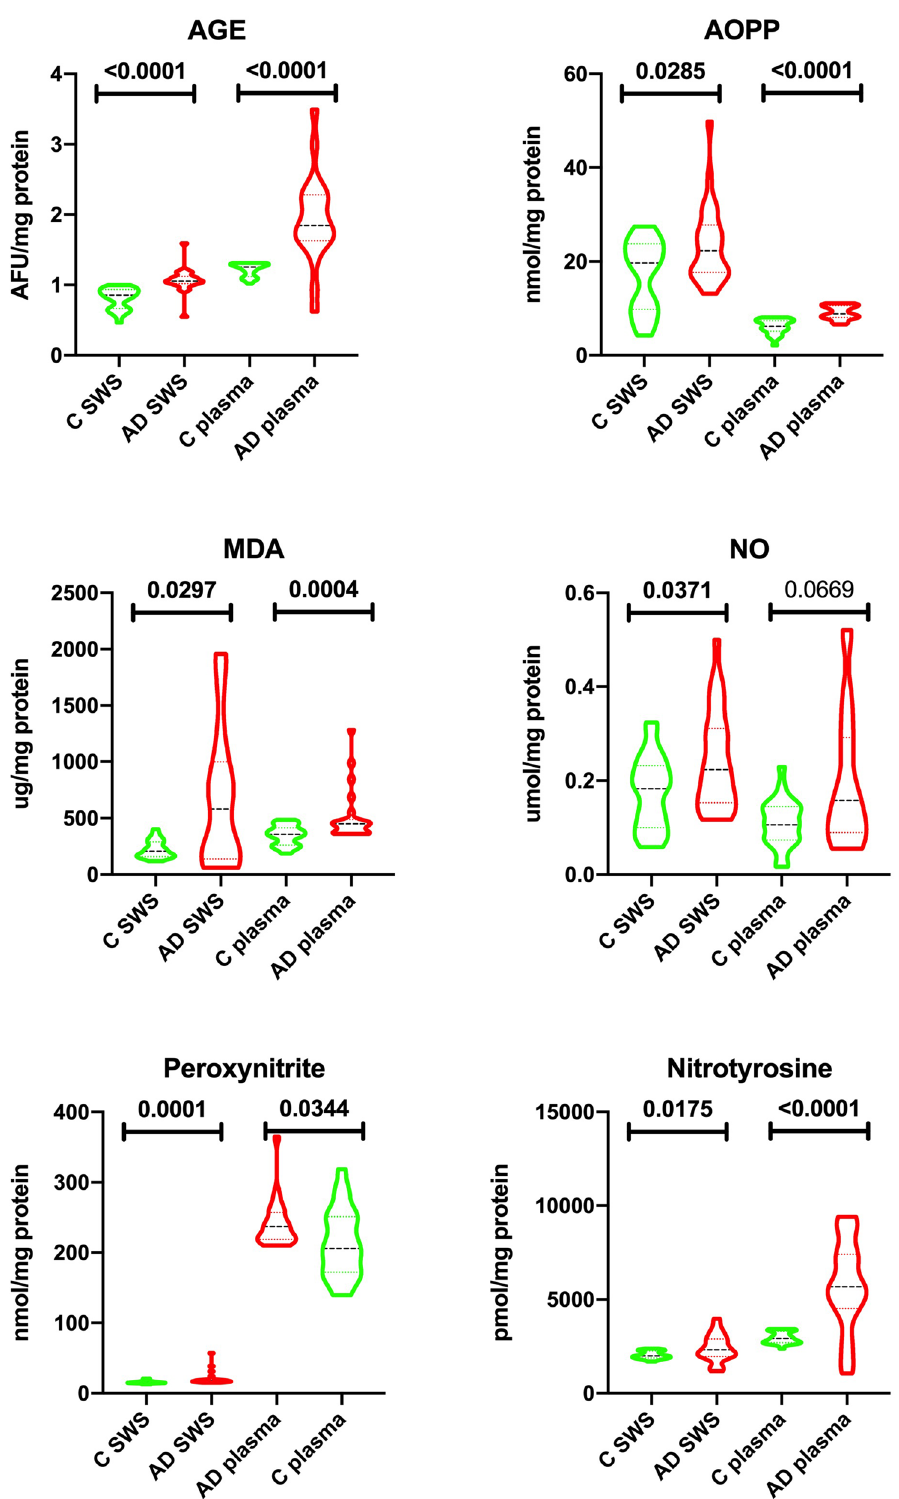
Figure 4. Salivary and erythrocytes/plasma oxidative and nitrosative stress in patients with Alzheimer’s disease and the control group. AGE—advanced glycation end products; AOPP—advanced oxidation protein products; MDA—malondialdehyde; NO—nitric oxide; C—control group; AD—Alzheimer’s disease group; SWS— stimulated whole